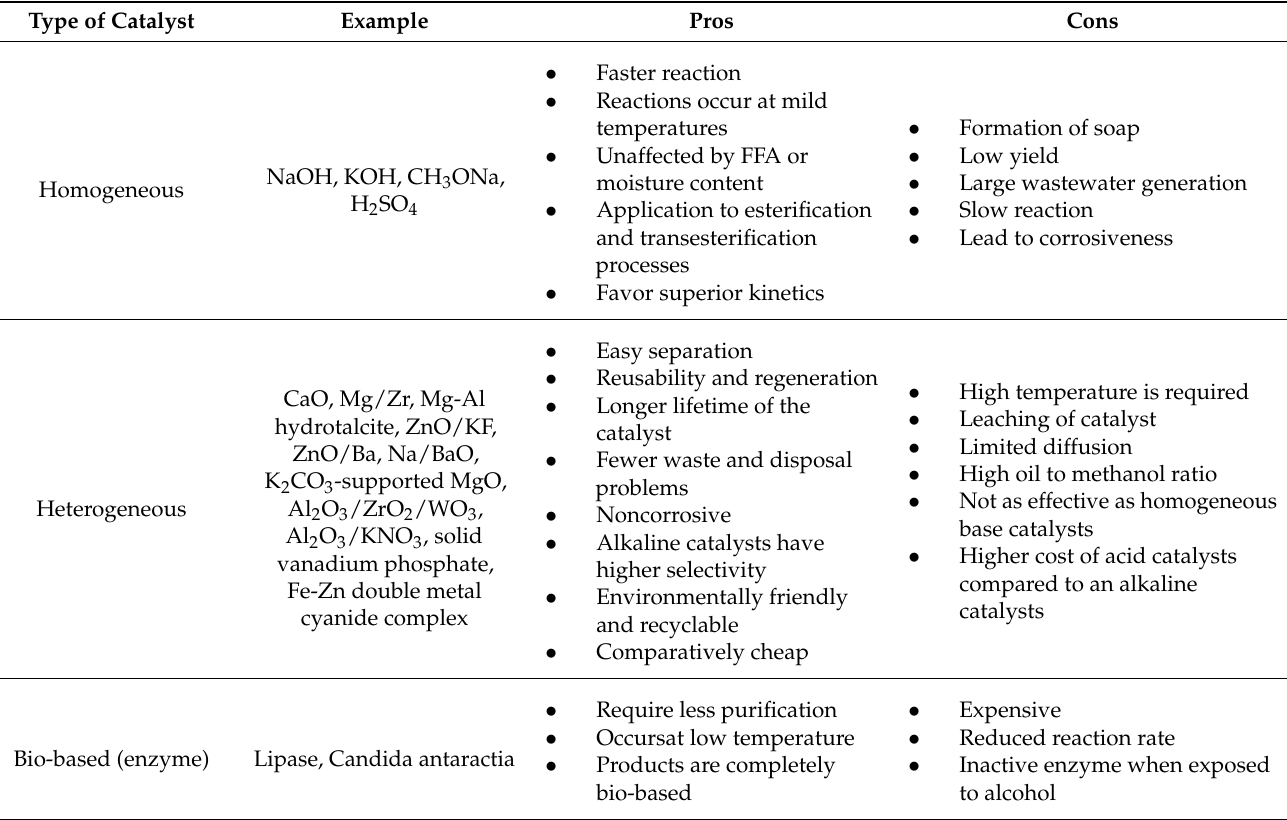
Table 8. Merits and demerits of various catalysts for the transesterification process